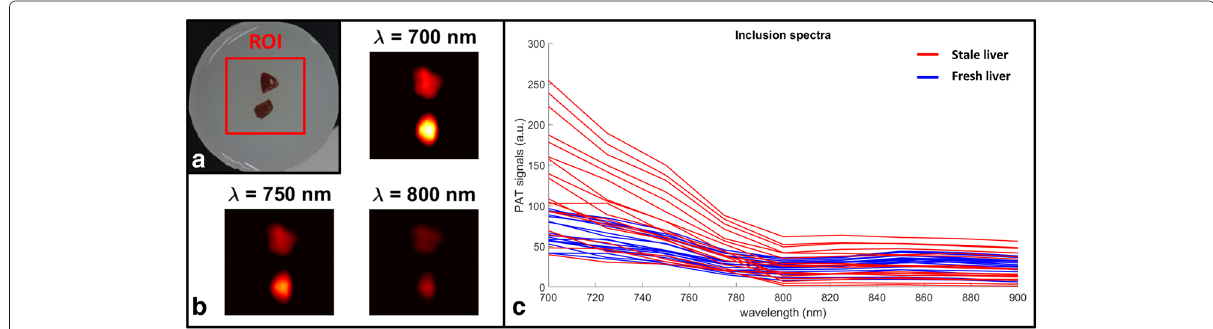
Fig. 4 Photoacoustic tomography acquisition for the liver phantom. a Phantom used for the discrimination study between fresh (upper, triangular) and stale (lower, rectangular; after 12 h in ambient air) pieces of liver tissue. b Three photoacoustic experimental ROI images after thresholding at different wavelengths. c Spectral profiles of the selected pixels from each